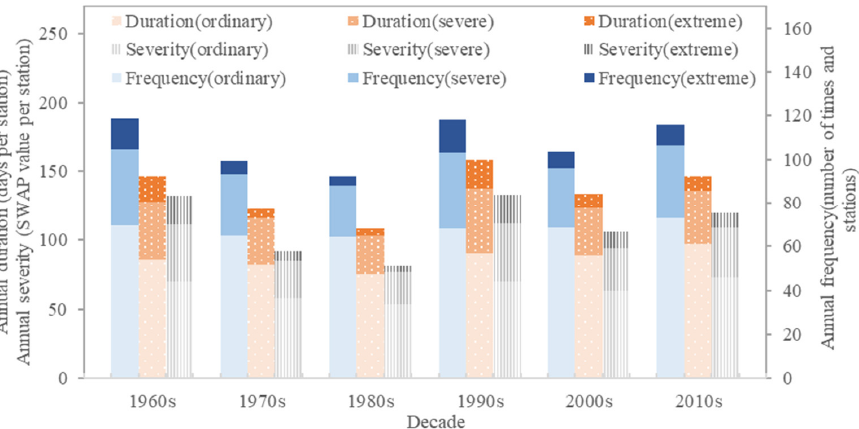
Figure 9. Decadal variation of annual duration, annual severity, and annual frequency of ordinary, severe, and extreme drought events.